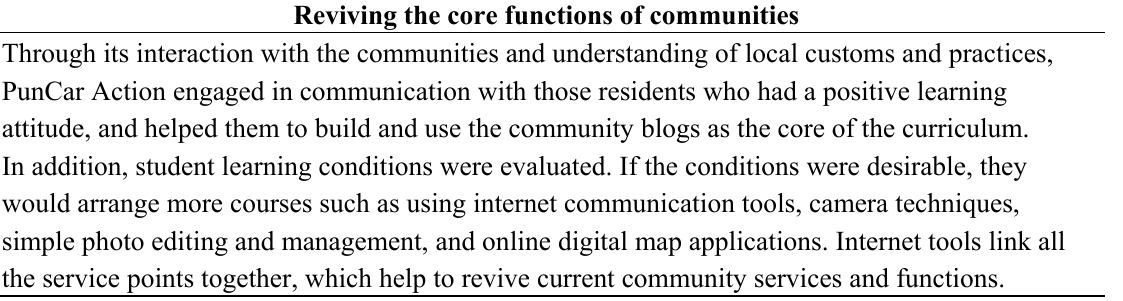
Table 4. Two categories of functional attributes of community